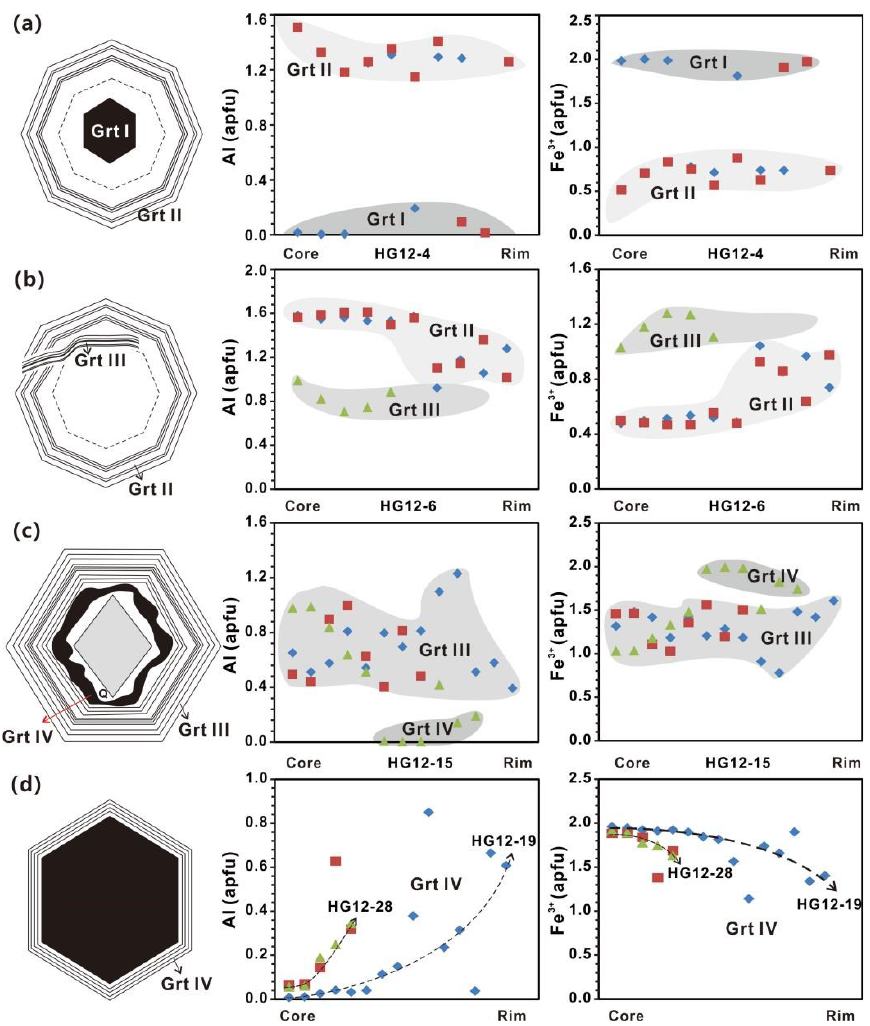
Figure 8. Four typical types of garnet morphology in the Huanggang deposit, and associated compositional variations.